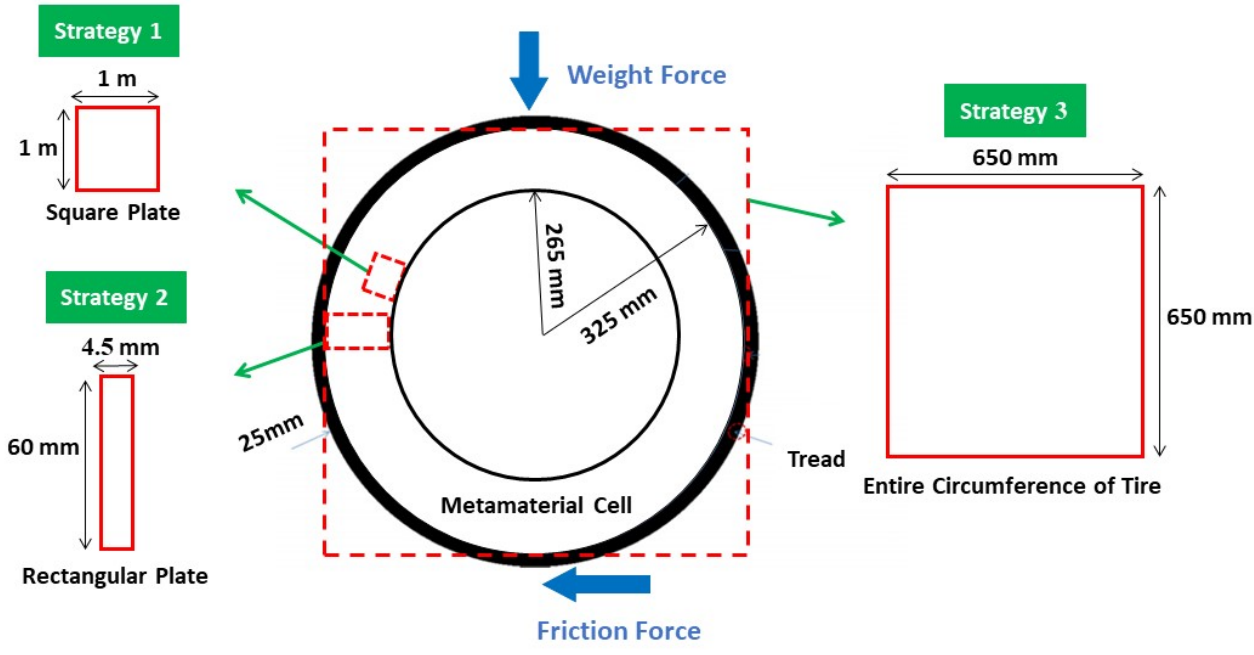
Figure 1. The dimensions of the tire plus the solution strategy. To optimize the non-pneumatic tire, three types of solution methods were considered. In the first case (Strategy 1), a non-pneumatic tire was obtained by optimizing a square plane and putting together the optimized response in the pneumatic part of the tire (after optimization, this cell can be used in a scaled form in the tire). In the second case (Strategy 2), a rectangular plane was chosen equal to the height of the pneumatic tire section,